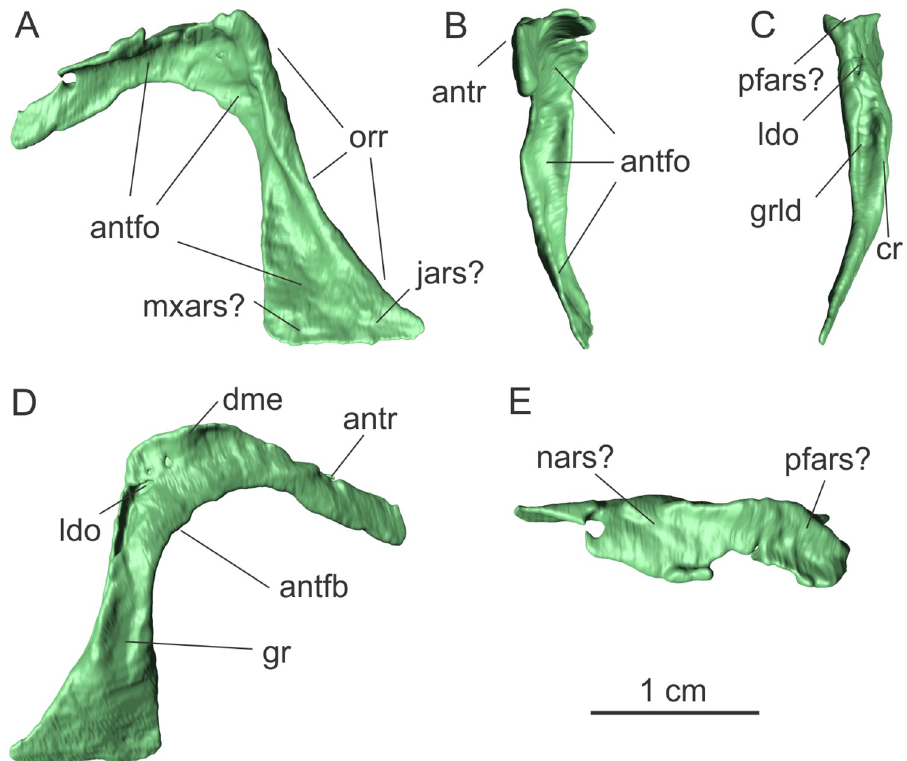
Fig 5. Left lacrimal of the specimen MCP-3845-PV of Saturnalia tupiniquim in lateral (A), anterior (B), posterior (C), medial (D), and dorsal (E) views. Abbreviations : antfb— border of the antorbital fenestra; antfo— antorbital fossa; antr— anterior ramus; cr— crest; dme— dorsomedial expansion; gr— groove; grld— groove associated with the lacrimal duct; jars— articulation surface with the jugal; ldo— lacrimal duct opening; nars— articulation surface with the nasal; mxars— articulation surface with the maxilla; orr —orbital rim; pfars— articulation surface with the prefrontal.